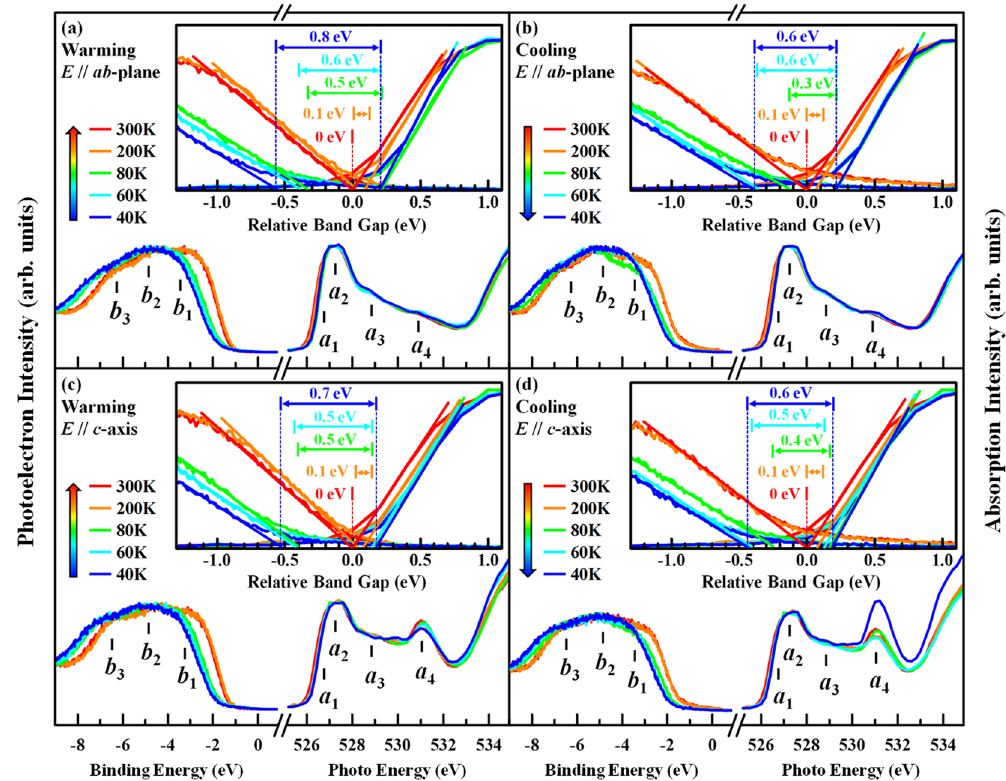
Figure 7. ( a – d ) Normalized VB-PES and O K -edge XANES spectra of a single crystal SrFeO 2.81 at two angles of incidence θ = 0° ( E // ab -plane) and 70° ( E // c -axis) during warming and cooling. VB-PES spectra are obtained at photon energy of 58 eV. Insets display linear fits to VB-PES and O K -edge XANES spectra at various temperatures and relative band